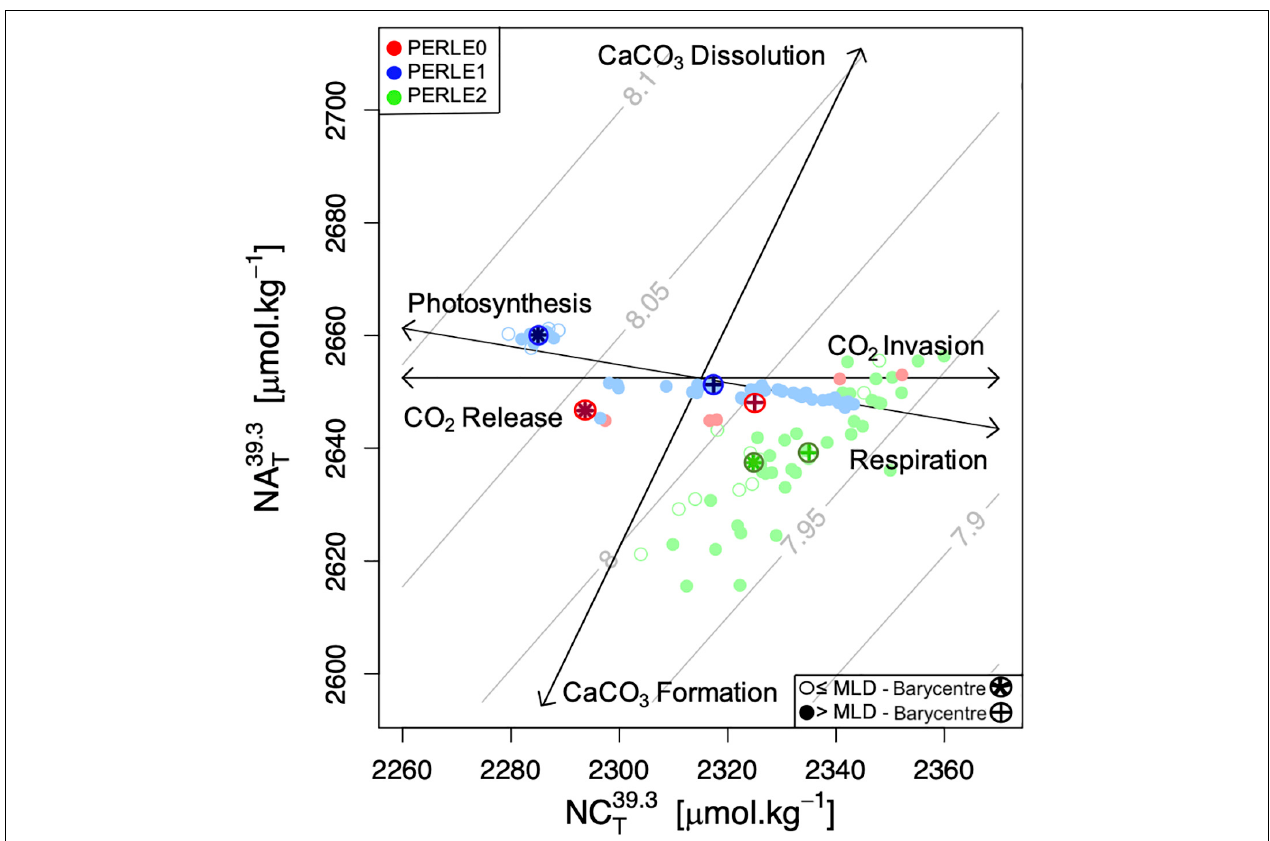
FIGURE 5 | Salinity-normalised A T (NA T 39 . 3 ) vs. salinity-normalised C T (NC T 39 . 3 ) during the three PERLE cruise in the upper 200 dbars for all stations situated in the North Western Levantine Basin. The layer of 0-200 dbars has been chosen as having the highest AOU variability because of the biological signal. Salinity-normalised values have been calculated with the mean PERLE salinity above 200 dbars ( i.e., 39.3). Empty and full dots represent data within and below the mixed layer, respectively. Circled crosses and circled stars represent the barycentre of data below and within the mixed layer, respectively. Black vectors reflect theoretical impacts of various processes (photosynthesis/respiration, carbonate dissolution/formation and CO 2 release/invasion) on A T and C T . Grey isolines indicate levels of constant pH T 25 as a function of A T and C T